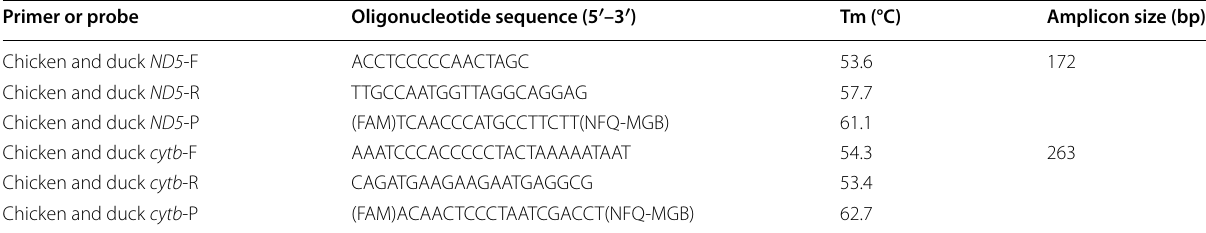
Table 1 Oligonucleotide sequences for quantitative PCR Primer or